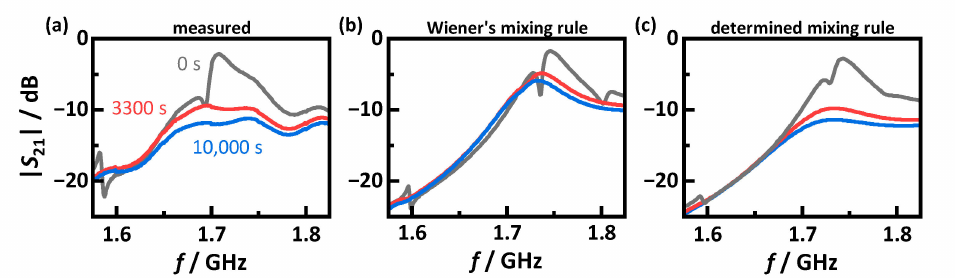
Figure 12. Frequency spectra of the transmission parameter | S 21 | at different times during filter loading: soot free filter at t = 0 s (black), before first regeneration at t = 3300 s and 472 mg/L GPF stored soot (red) and after three regenerations and subsequent soot loading at t = 10,000 s and 730 mg/L GPF stored soot (blue); ( a ) measured data; ( b ) simulated data using Wiener’s mixing rule to consider the air content; ( c ) simulated data using the mixing rule determined in Section